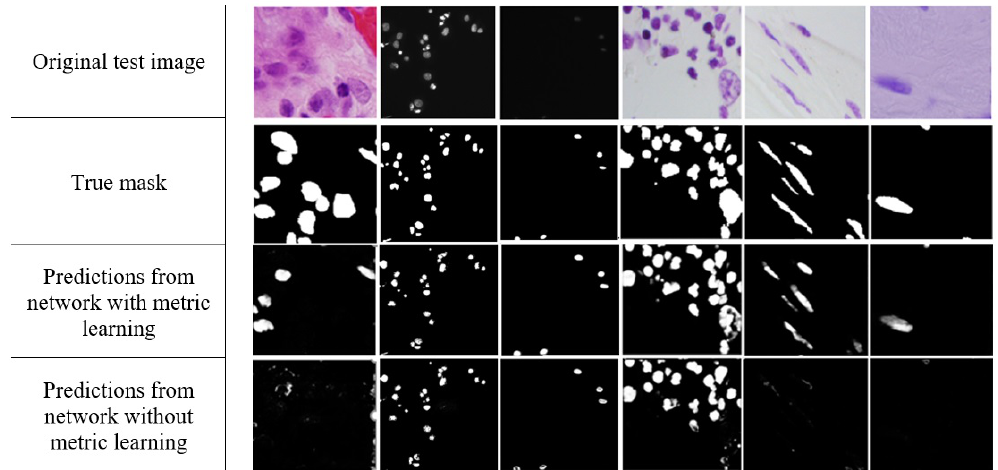
Figure 5. From top to bottom: original test image, its true mask, the predictions using the network with metric learning (triplet loss with semi-hard negative mining), and the predictions using the network without metric learning.